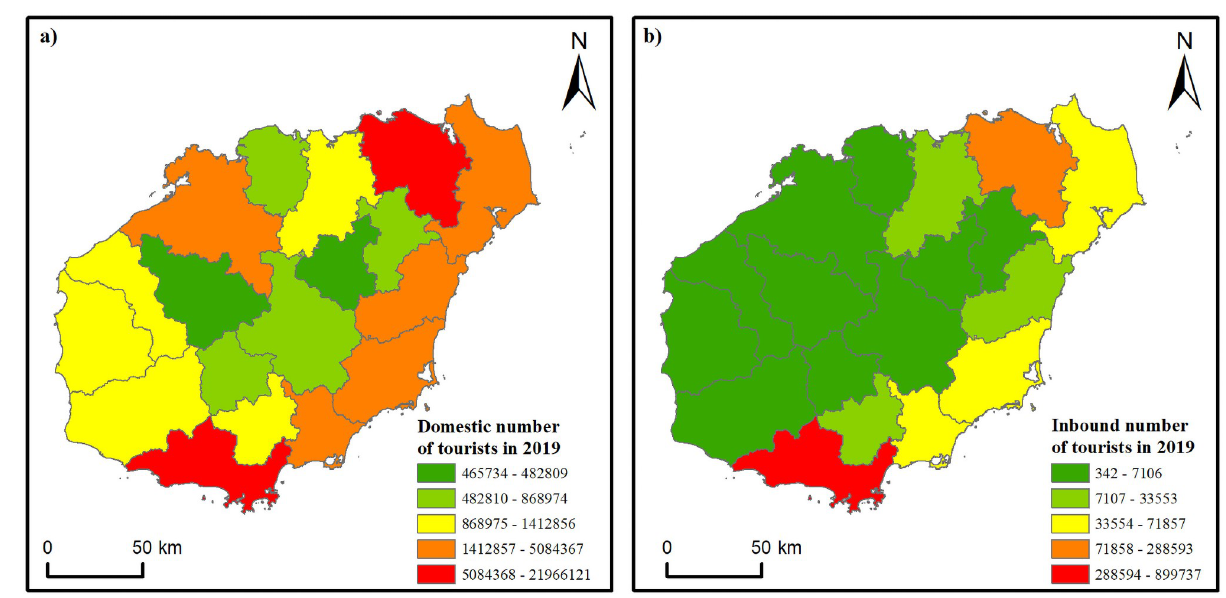
Fig 5. The spatial pattern of (a) domestic tourists and (b) inbound tourists in 2019 on Hainan